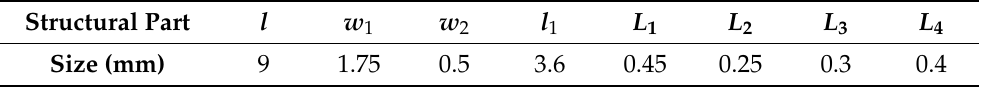
Table 1. The specific dimensions of the actuator and transmission